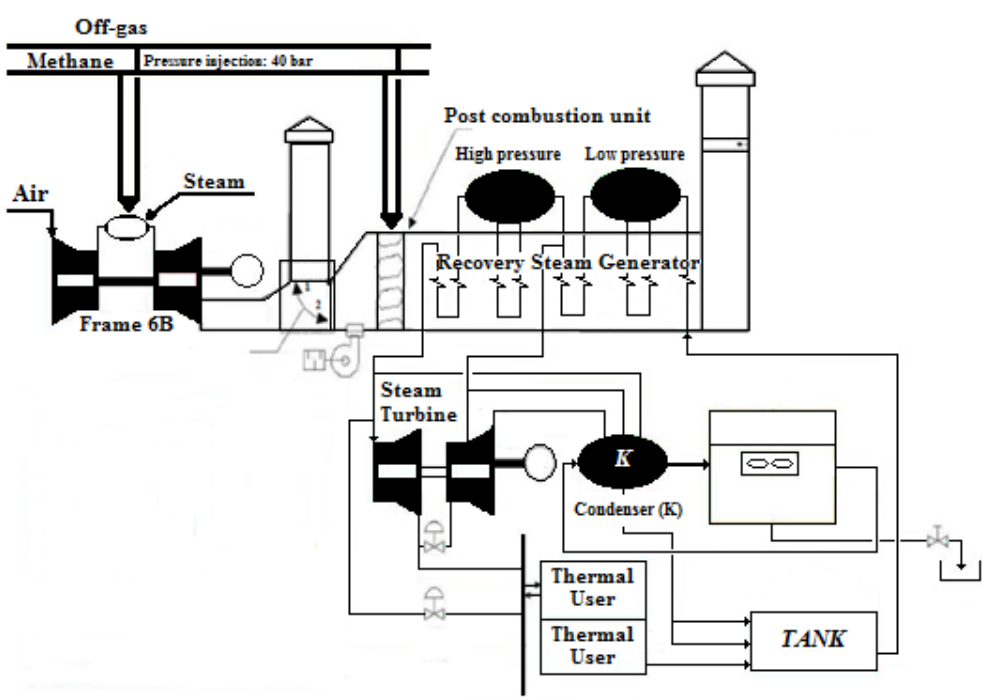
Figure 1. Power plant schematization.